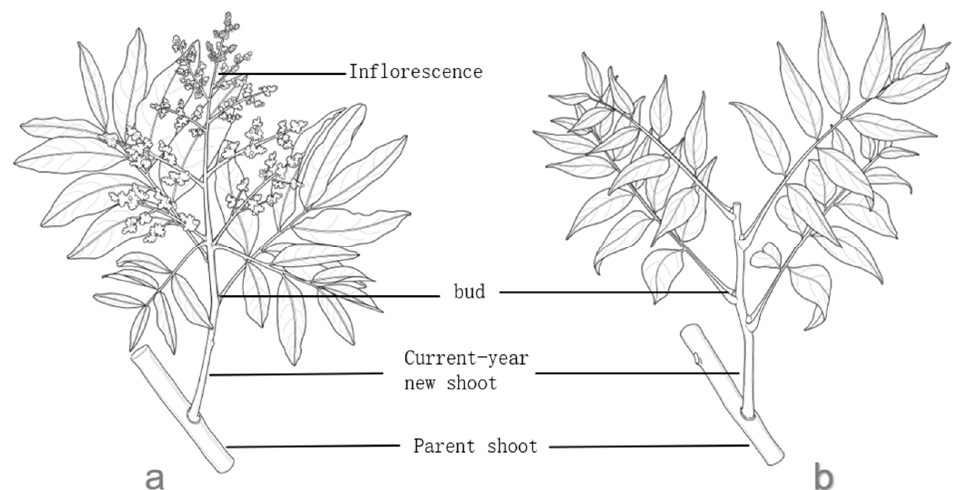
Figure 1. Schematic of the current-year new shoots on parent shoot. ( a ) bearing shoot of the current- year new shoot; ( b ) vegetative shoot of the current-year new shoot.